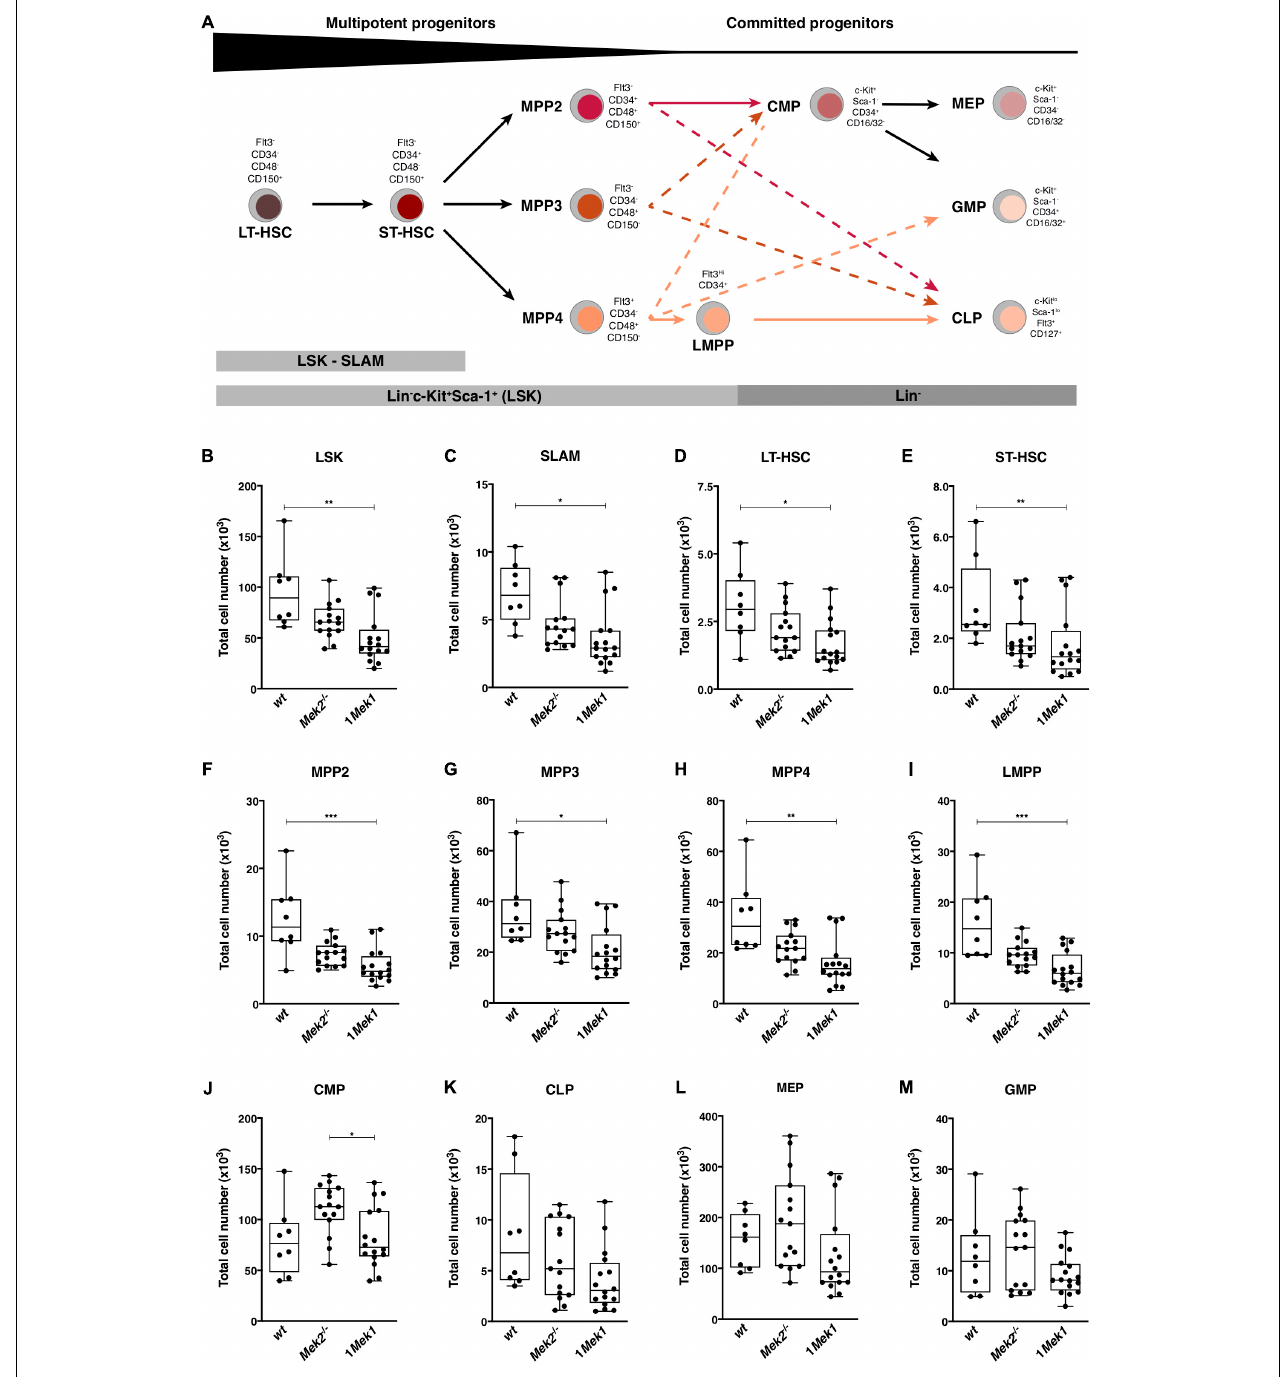
FIGURE 7 | Reduced numbers of HSCs and multipotent HSC progenitors in bone marrow from 1 Mek1 mutants. (A) Schematic representation of lineage determination in the mouse hematopoietic system with the flow cytometric gating strategy used to monitor the major classes of mouse hematopoietic stem and progenitor cells. (B–M) 1 Mek1 mutant mice displayed a cell autonomous reduction in multipotent progenitors and lymphoid-biased progenitors in the bone marrow. Absolute numbers of LSK ( B , Lin − c-Kit + Sca-1 + ), SLAM ( C , Lin − c-Kit + Sca-1 + CD48 − CD150 + ), LT-HSC ( D , Lin − c-Kit + Sca-1 + CD48 − CD150 + Flt3 − CD34 − ), ST-HSC ( E , Lin − c-Kit + Sca-1 + CD48 − CD150 − Flt3 − CD34 − ), MPP2 ( F , Lin − Sca-1 + c-Kit + Flt3 − CD34 − CD48 + CD150 + ), MPP3 ( G , Lin − Sca-1 + c-Kit + Flt3 − CD34 − CD48 + CD150 − ), MPP4 ( H , Lin − Sca-1 + c-Kit + Flt3 + CD34 − CD48 + CD150 − ), LMPP ( I , Lin − c-Kit + Sca-1 + Flt3 high CD34 + ), CMP ( J , Lin − c-Kit + Sca-1 − CD34 + CD16/32 − ), CLP ( K , Lin − c-Kit low Sca-1 low Flt3 + CD127 + ), MEP ( L , Lin − c-Kit + Sca-1 + CD34 − CD16/32 − ), and GMP ( M , Lin − c-Kit + Sca-1 − CD34 + CD16/32 + ) in bone marrow of wt , Mek2 − / − , and 1 Mek1 mutants are presented. Data are from at least four independent experiments. The results are presented as whiskers-and-boxes graph, and each dot represents an individual mouse. ANOVA with Kruskal–Wallis multiple-comparisons test was performed. * P < 0.05, ** P < 0.01, *** P < 0.001.